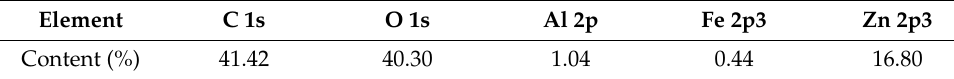
Figure 5. XPS spectra of Zn 2p3, O 1s, Al 2p, and Fe 2p3 peaks in codoped (Al:Fe = 1) film. ( a ) Zn 2p3, ( b ) O 1s, ( c ) Al 2p, ( d ) Fe 2p3. 3.4. Optical Property Figure 6 displays the transmittance spectra of different ZnO films. It can be observed that the transmission of all films is higher than 80% in the visible region of 400–800 nm. Compared with the ZnO film, the doped films have higher transmission, and the trans ‐ mission of codoped (Al:Fe = 3) film can even reach up to about 90%. However, the trans ‐ mission of codoped (Al:Fe = 1) and codoped (Fe:Al = 3) films is slightly lower that of Al doped films. Moreover, all films shows a strong absorption in the ultraviolet region of 300–400 nm, which is attributed to the intrinsic absorption originated from the direct tran ‐ sition of electrons [26]. It can also be noted that the absorption edge of the films shifts to the short ‐ wavelength direction after doped, which is in agreement with that reported in the literature [27,28]. This might be attributed to the reduction of surface roughness [29], which is accordant with the result of SEM observation. According to the formula of Eg =